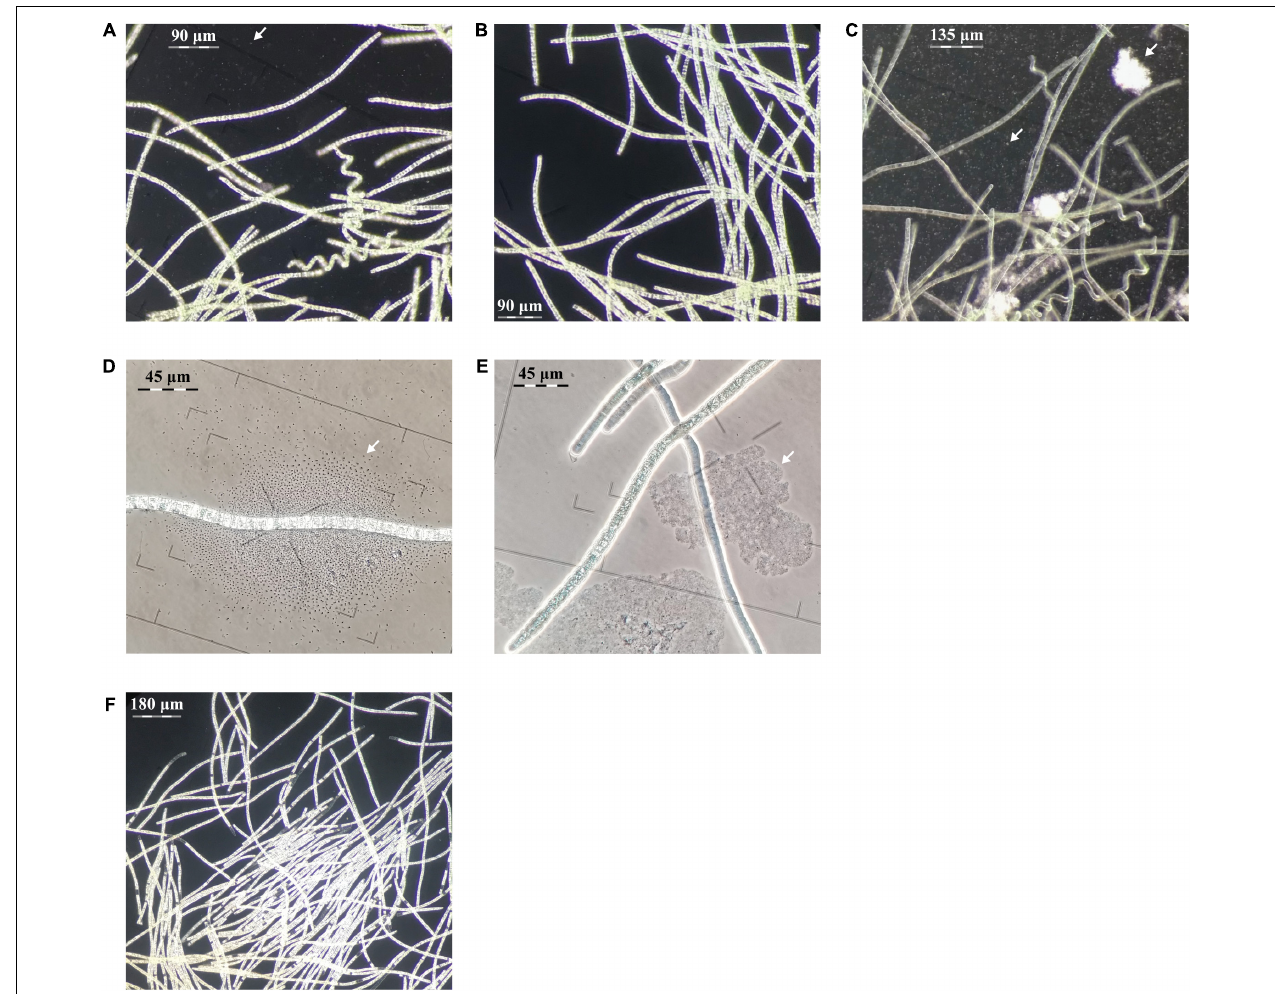
FIGURE 2 | Evaluation of centrifugation, elevated pH and antibiotic purification methods for L. fusiforms (contaminants shown with arrows). (A) Buoyant cells obtained from a culture of L. fusiformis before any treatment that contained contaminants. Applying only centrifugation resulted in (B) a surface layer of partially purified trichomes and (C) a pellet containing debris and contaminants. (D) Buoyant cells obtained from a culture of L. fusiformis before any treatment. (E) Applying only elevated pH (12.15 pH for 4 days) resulted in a culture with lysed contaminants (likely Microcystis sp. based on morphology; Sant’Anna et al., 2008). (F) The combination of filtration, centrifugation (B) , pH treatments (E) , and an antibiotic cocktail resulted in an axenic L. fusiformis